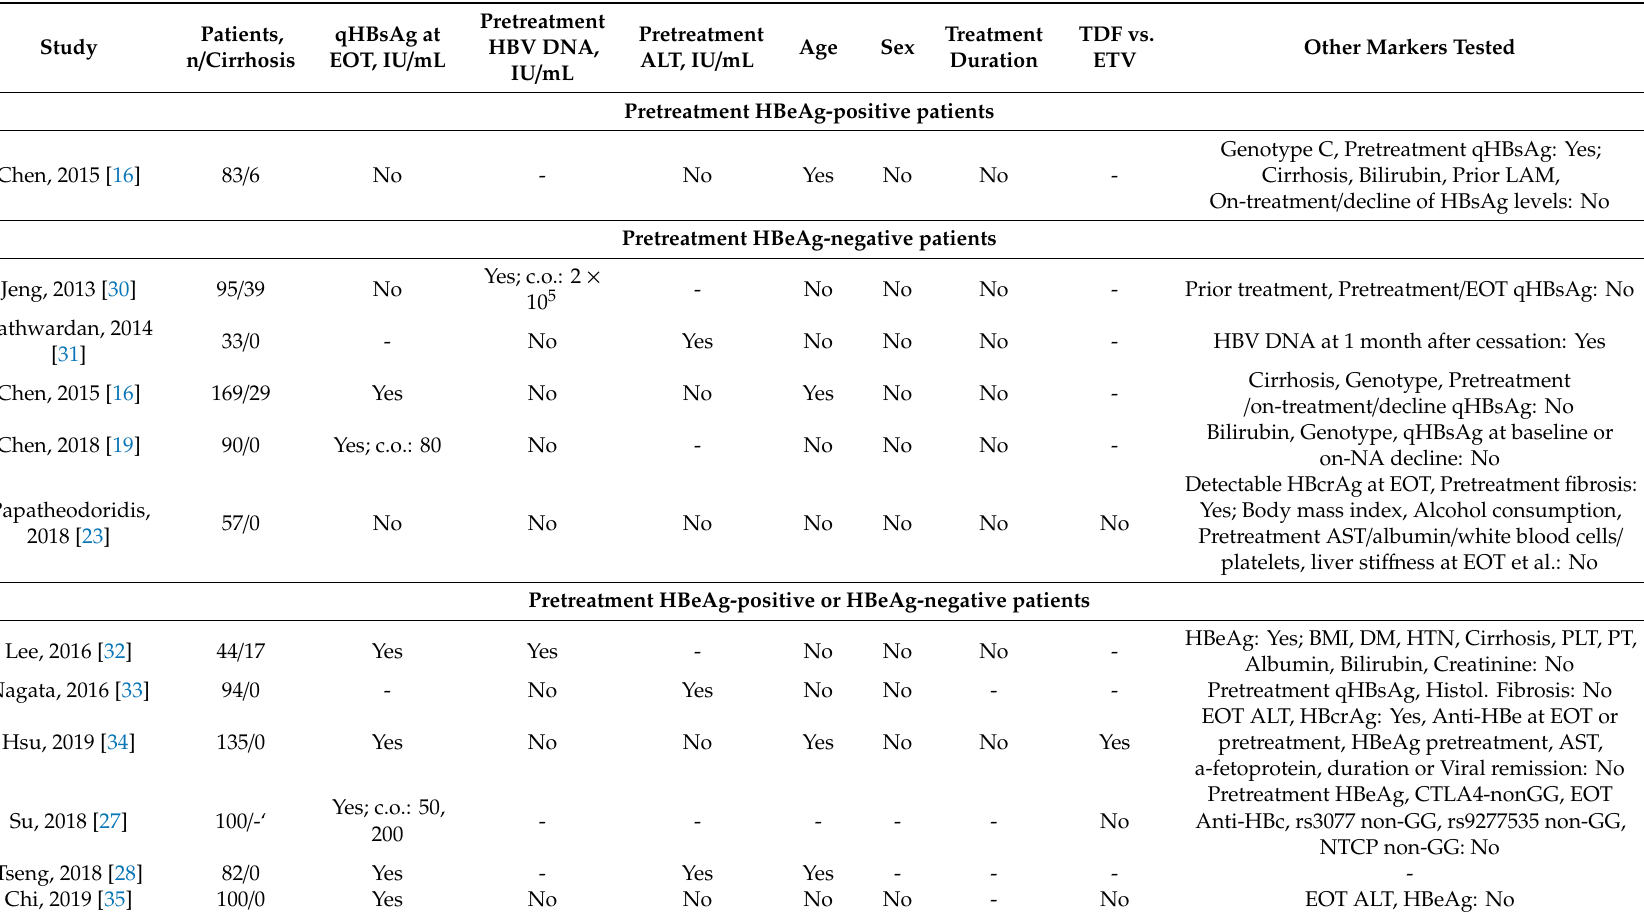
Table 2. Predictors of clinical relapse after discontinuation of nucleos(t)ides analogues (NAs) in studies including chronic hepatitis B (CHB) patients who remained HBsAg positive at the end of therapy (EOT). Predictors are provided separately for pretreatment HBeAg-positive patients who achieved HBeAg seroconversion and pretreatment HBeAg-negative patients, when available, or mixed patients when separate analyses were not